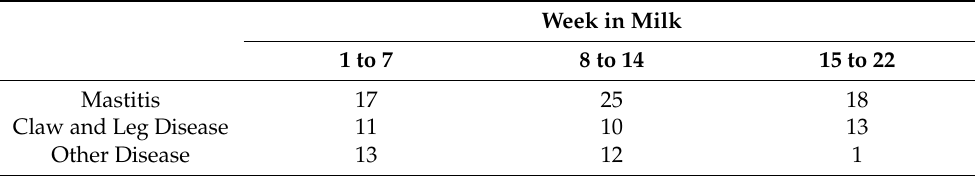
Table 2. Number of diagnoses according to disease category and stage of lactation.